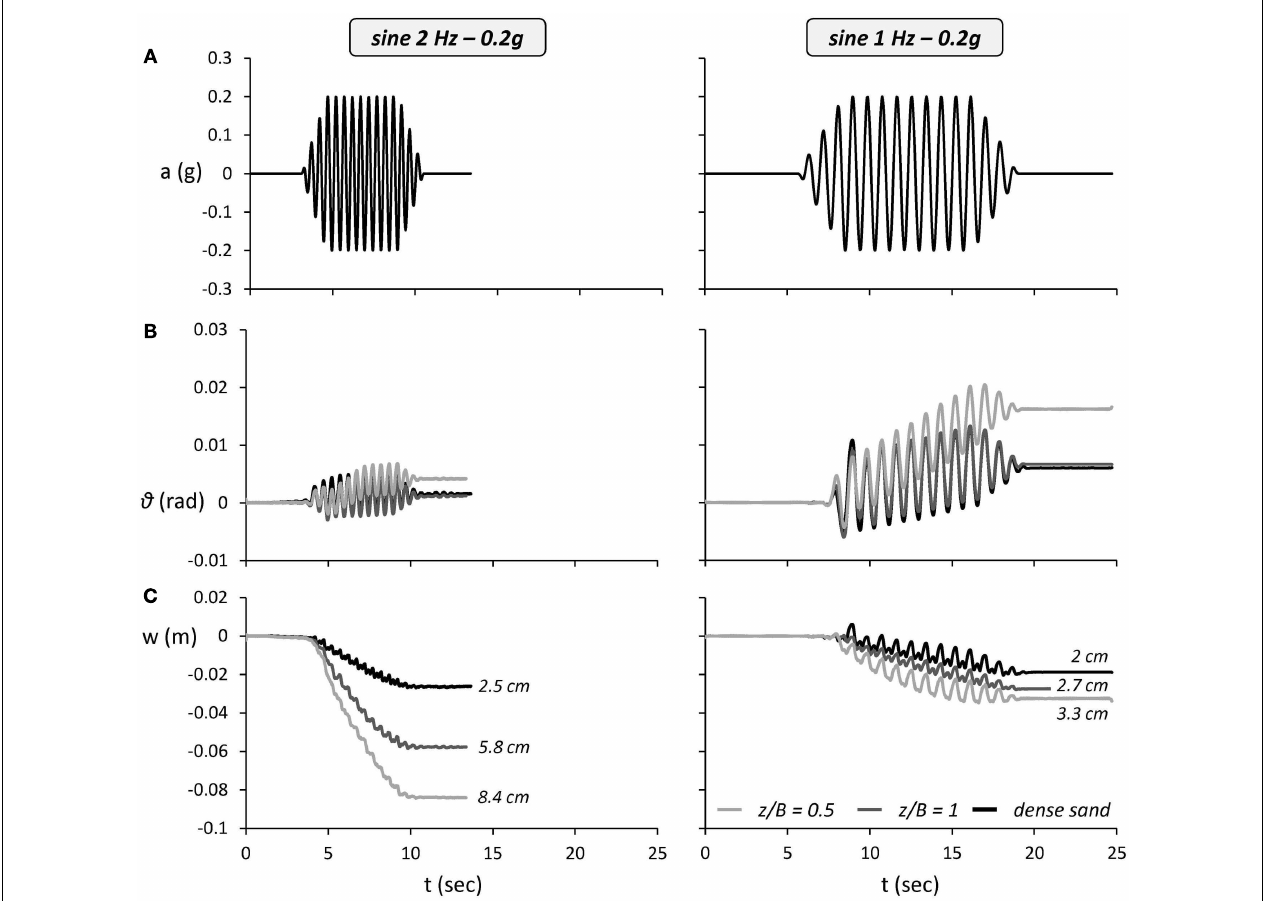
using two 15-cylce sinusoidal excitations of frequency f = 2Hz (left) and f = 1Hz (right). Time histories of (A) free field and base excitation, (B) foundation rotation, and (C)